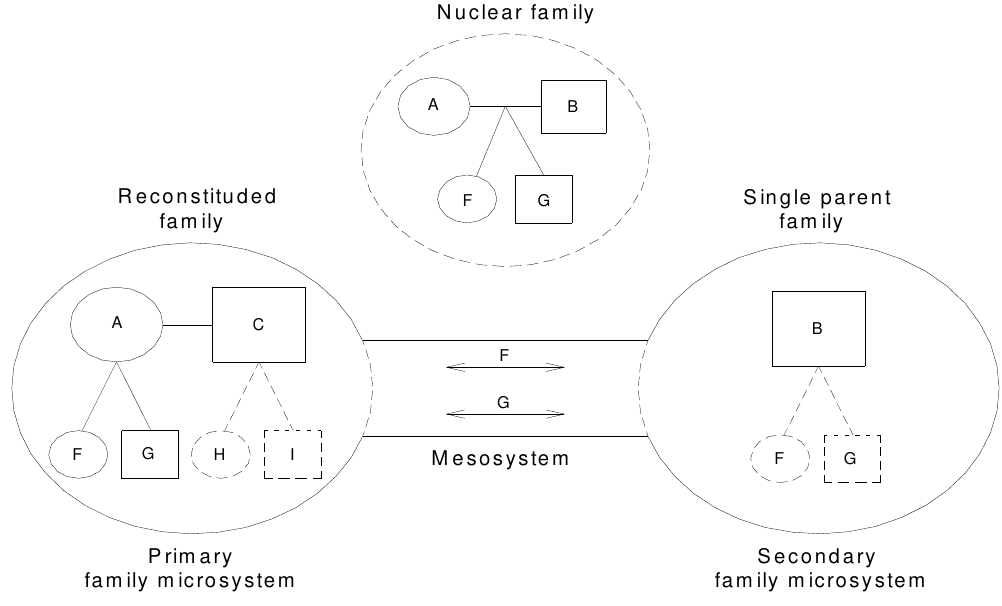
Figure 3 The primary and secondary family microsystems of the children of divorced Spouses A and B, where